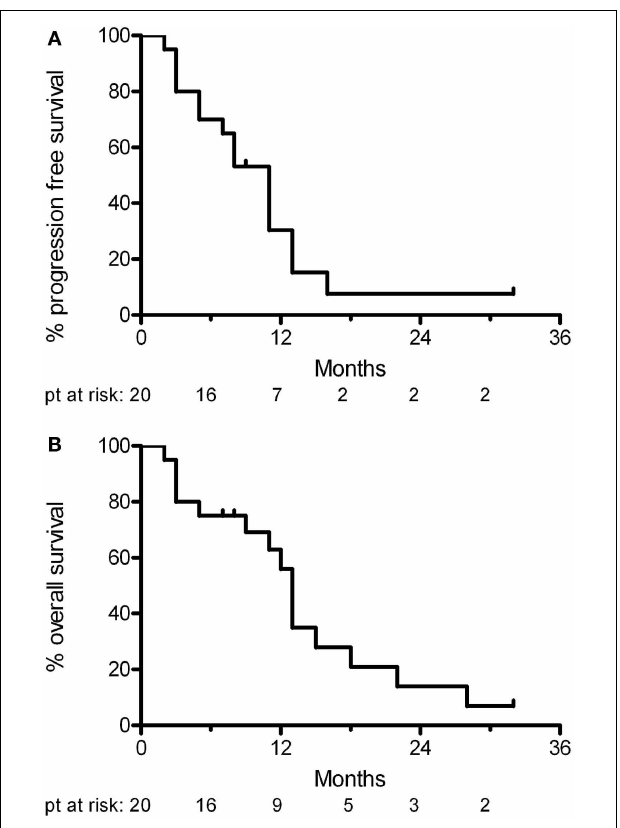
FIGURE 2 | Kaplan–Meier analysis of (A) progression free survival and (B) overall